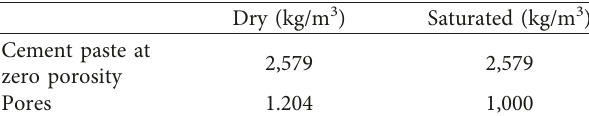
Table 2: Densities of dry and saturated phases